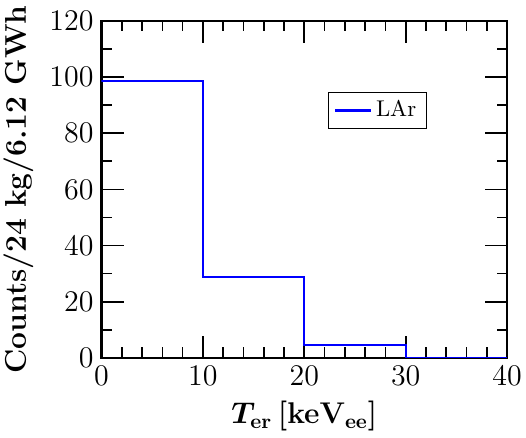
Figure 1 . Simulated number of events at the CENNS-10 LAr detector as a function of the electron recoil energy T er